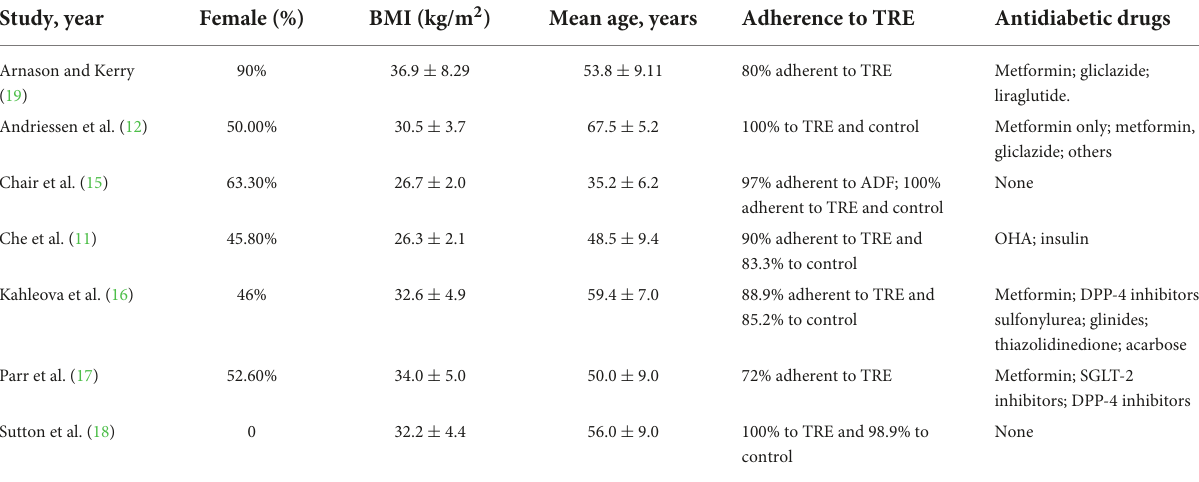
TABLE 2 The characteristics of